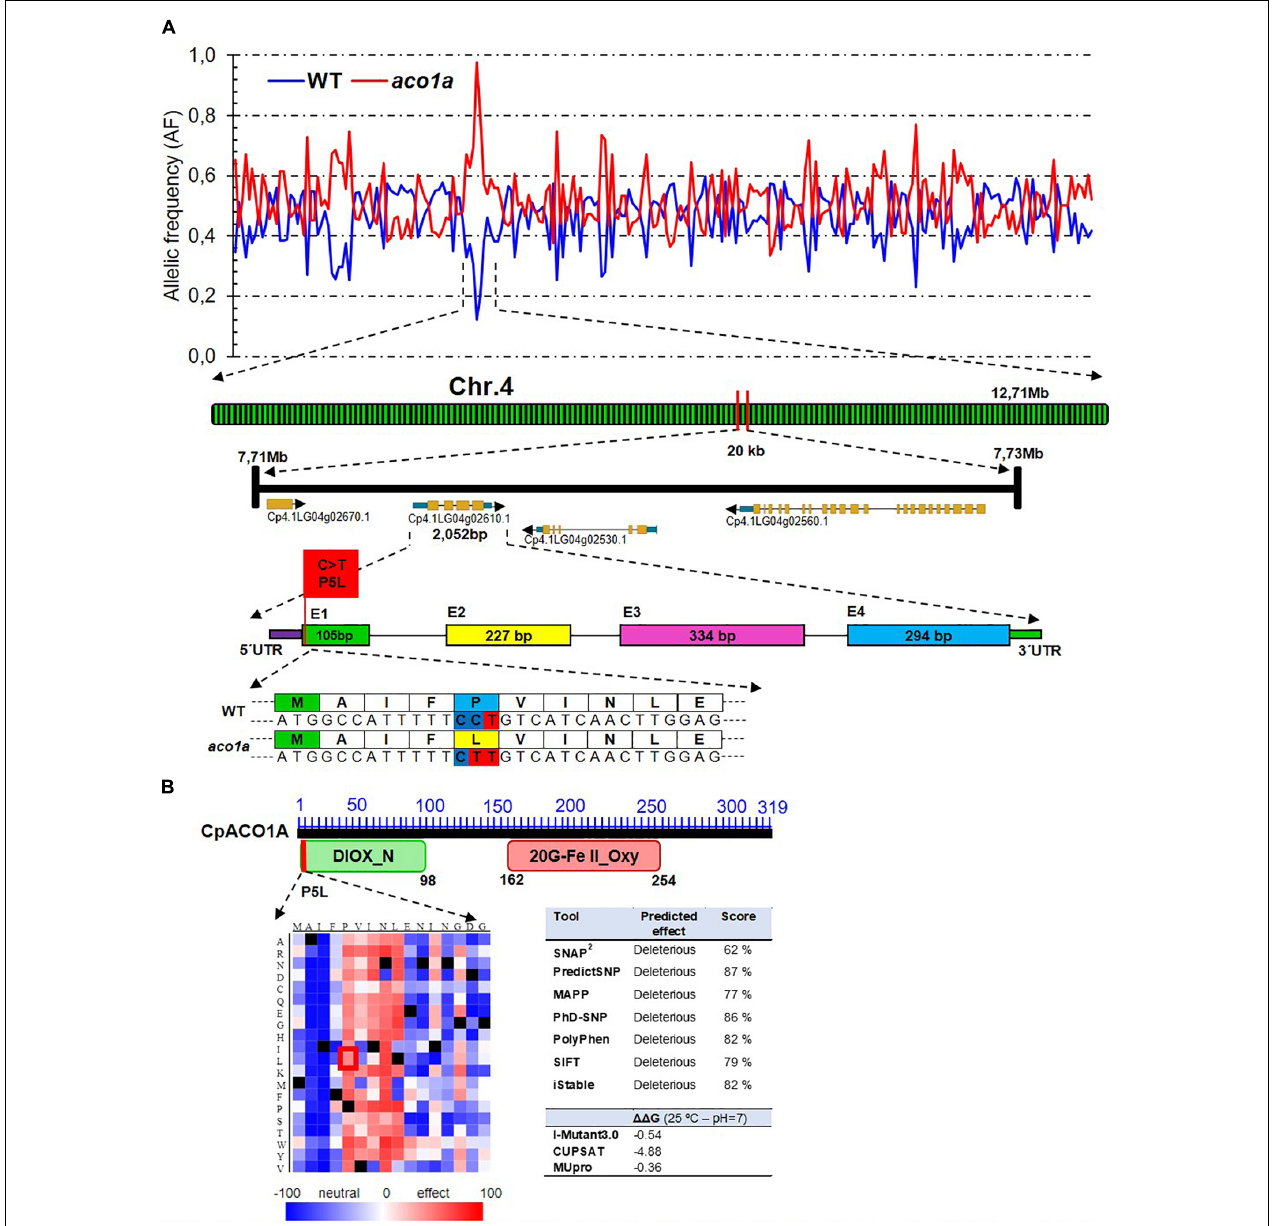
FIGURE 3 | Identification of aco1a causal mutation by BSA-sequencing. (A) Frequency of the alternate allele in the WT and aco1a bulks along the physical map of squash genome. The analysis indicates that a region of chromosome 4 is responsible for the mutant phenotype. A missense mutation on the gene Cp4.1LG04g02610.1 ( CpACO1A ) produces a change of proline by leucine at residue 5 (P5L) of the ethylene biosynthesis enzyme CpACO1A. (B) Impact of P5L mutation in the N-terminal conservative non-heme dioxygenase DIOX_N region of ACO enzymes. The SNAP 2 -generated heatmap of CpACO1A N-domain indicates that changes in residue 5–9 have a high impact on protein function. The red box indicates the impact of the aco1a mutation. The table on the right shows the predicted effect of the mutation on protein function and stability by using different bioinformatics